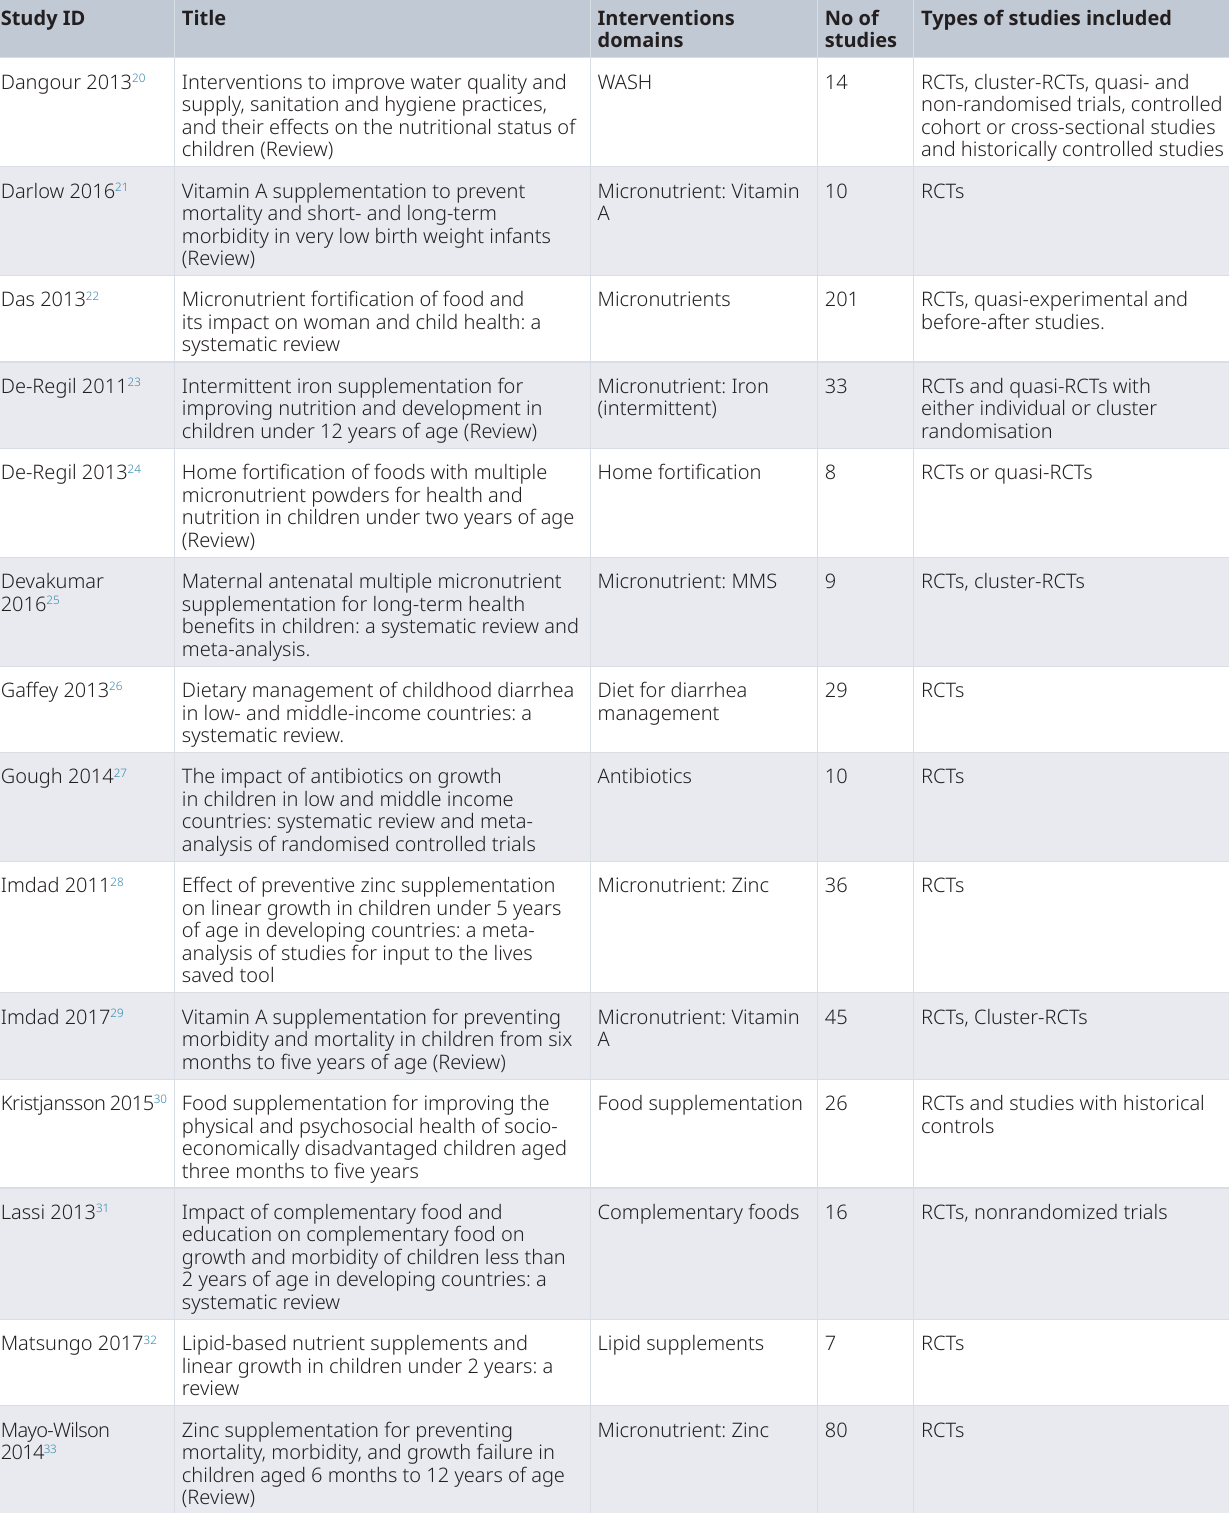
Table 1. Existing reviews on interventions for children aged 6 to 24 months. Study